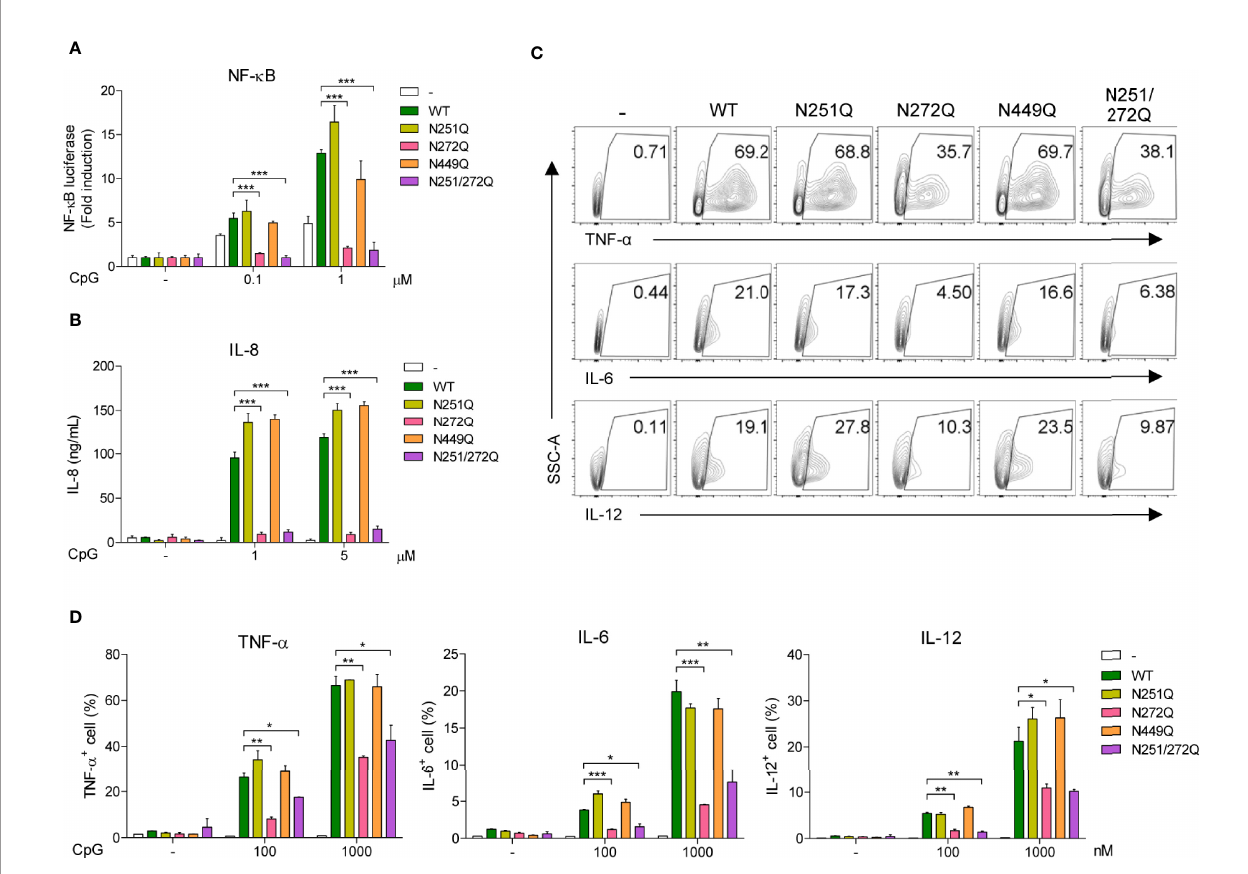
FIGURE 5 | Defective glycosylation at N272 residue of UNC93B1 inhibits TLR9 signaling. (A) HEK293T cells expressing the NF- k B-luciferase reporter, TLR9-myc, and UNC93B1-HA (wild type or mutant) were stimulated with indicated concentration of CpG DNA for 6 h. After cell lysis, the luciferase activity was measured and the fold induction of luciferase in stimulated cells over unstimulated cells were depicted. (B) HEK293T cells expressing TLR9-myc and UNC93B1-HA (wild type or mutant) were stimulated with indicated concentration of CpG DNA for 24 h. IL-8 secreted in the cell supernatant was measured by ELISA. (C, D) GFP or UNC93B1- GFP (wild type or mutant) was expressed in UNC93B1 KO BMDCs. After stimulation of cells with CpG DNA for 4 h, cytokine production was analyzed by intracellular cytokine staining followed by fl ow cytometry. Representative FACS plots for TNF- a , IL-6, and IL-12 in GFP + cells are shown (C) . The proportion of TNF- a + , IL-6 + , and IL-12 + cells among GFP + populations are shown (D) . Data represent means ± SD (n = 3). *p < 0.05, **p < 0.01, ***p < 0.001 (Student ’ s t